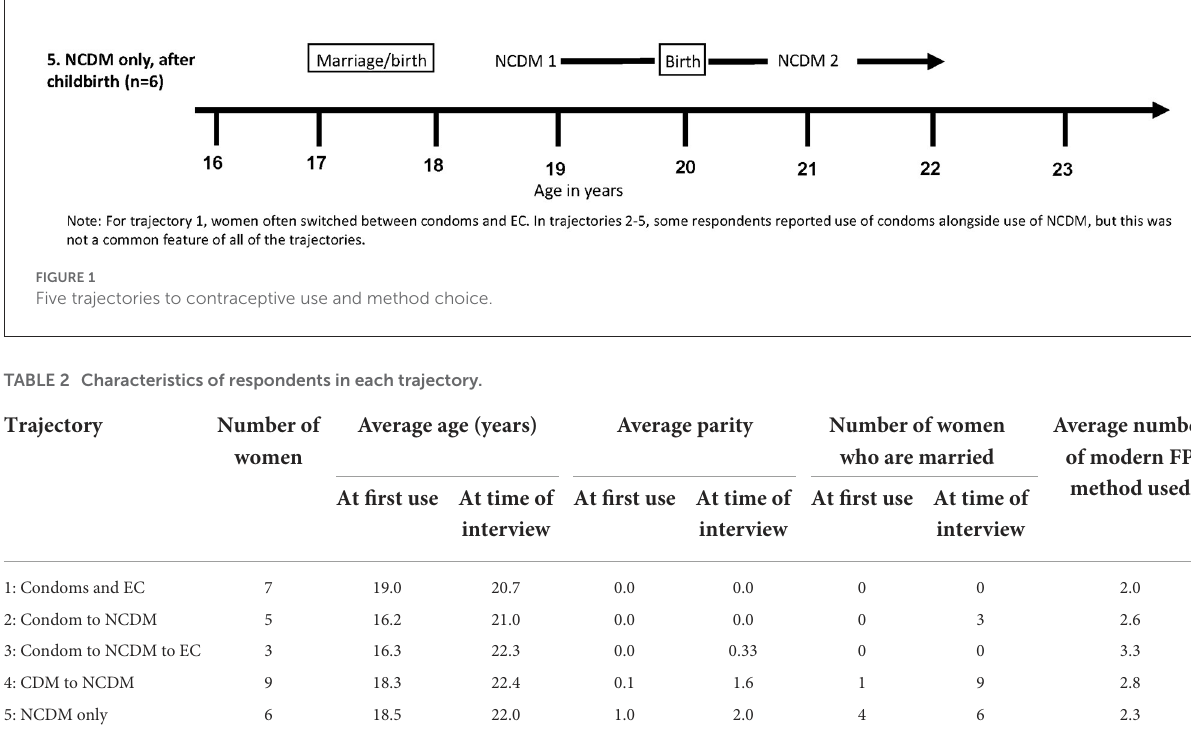
Average age (years) Average parity Number of women Average number women who are married of modern FP method used At first use At time of At first use At time of At first use At time of interview interview